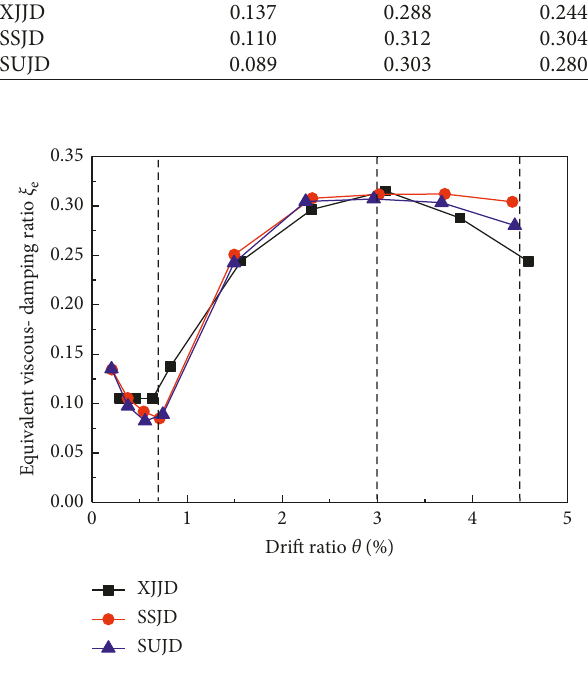
Figure 17: Equivalent damping